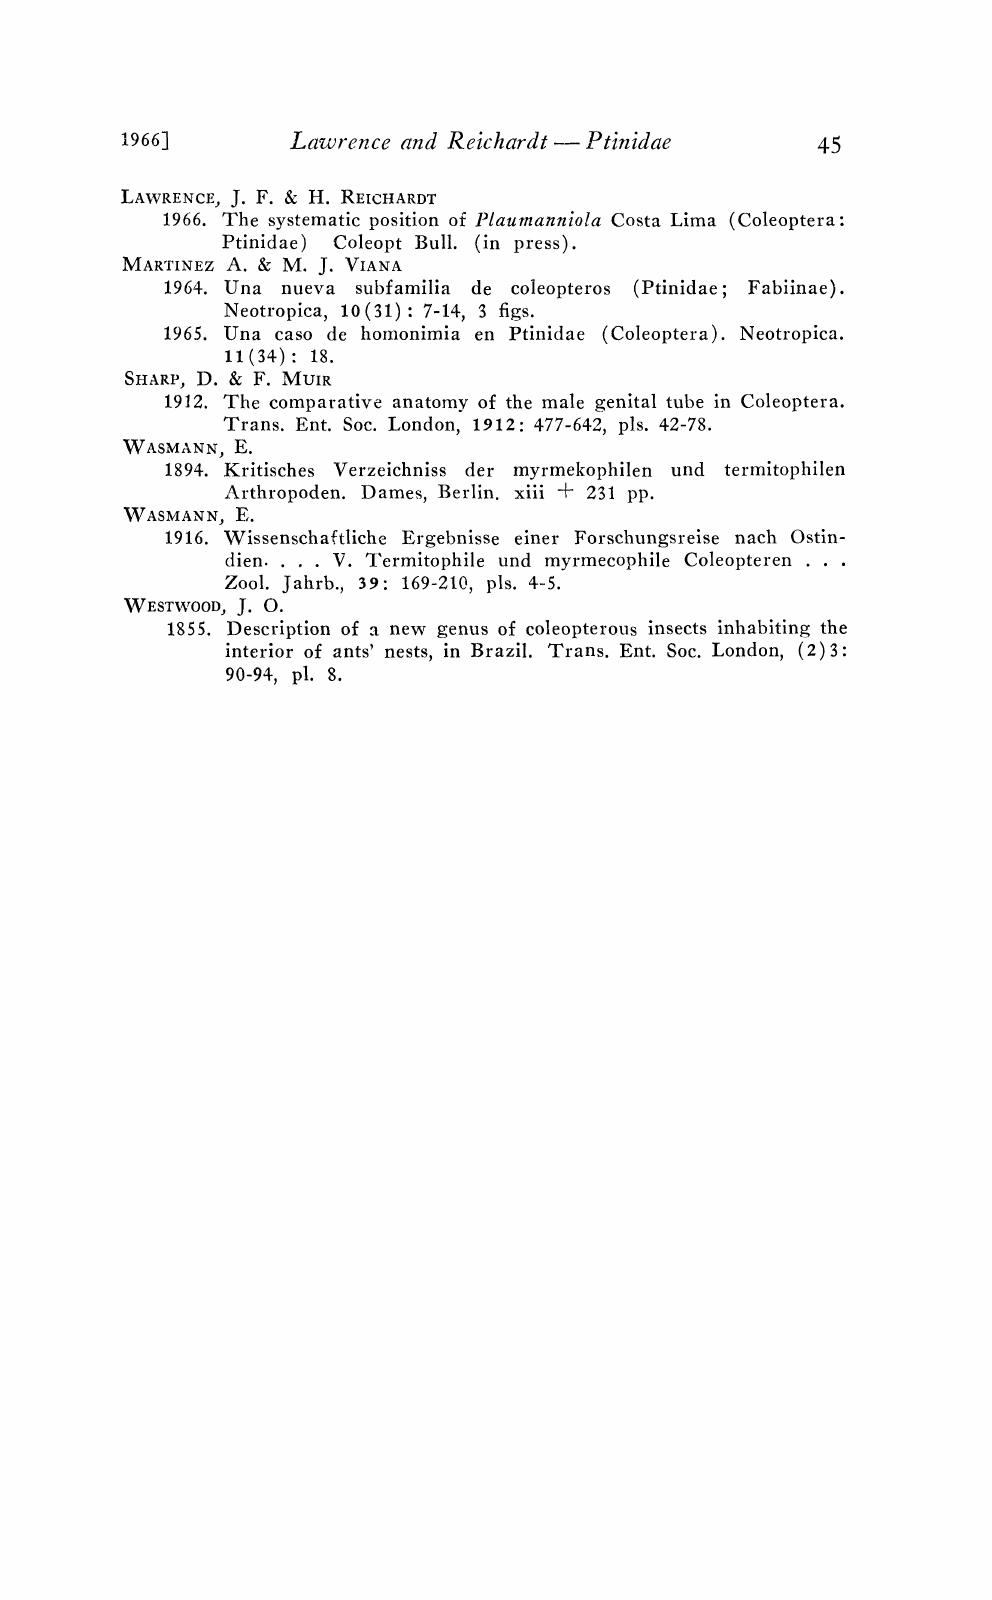
1965. Una caso de homonimia en Ptinidae (Coleoptera). Neotropica. 11(34):